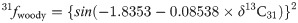
Bivariate relationships shared between surface-sediment LEWIS, δ13C31 values and fractional tree cover (MODISfwoody) estimates of (sub)tropical African source-region vegetation communities.Larger circle sizes and darker shading (green) both represent increased fractional tree cover (c.f., Fig 1). Light blue shaded bounds indicate empirical 90% confidence intervals as calculated from a Monte Carlo method [92]. Asymptotic significance (p-value) is less than 0.0001 for all the relationships shown. A, Biomarker reconstructions of fractional tree cover (31fwoody) were calculated from δ13C31 values with a nonlinear equation [35]:
31fwoody={sin(−1.8353−0.08538×δ13C31)}2
B, Biplot between satellite-estimated fractional tree cover (MODISfwoody) and biomarker-reconstructed fractional tree cover (31fwoody). C, Relationship shared between surface-sediment LEWIS and δ13C31 values. Also shown are median values and the median absolute deviation of dominant PFTs (S1 Table) [15]: C3 woody plants [n = 37 (white diamond)], C3 forbs [n = 22 (double diamond)], and C4 grasses [n = 84 (black diamond)]. D, Relationship shared between surface-sediment LEWIS values and fractional tree cover (MODISfwoody) estimates.